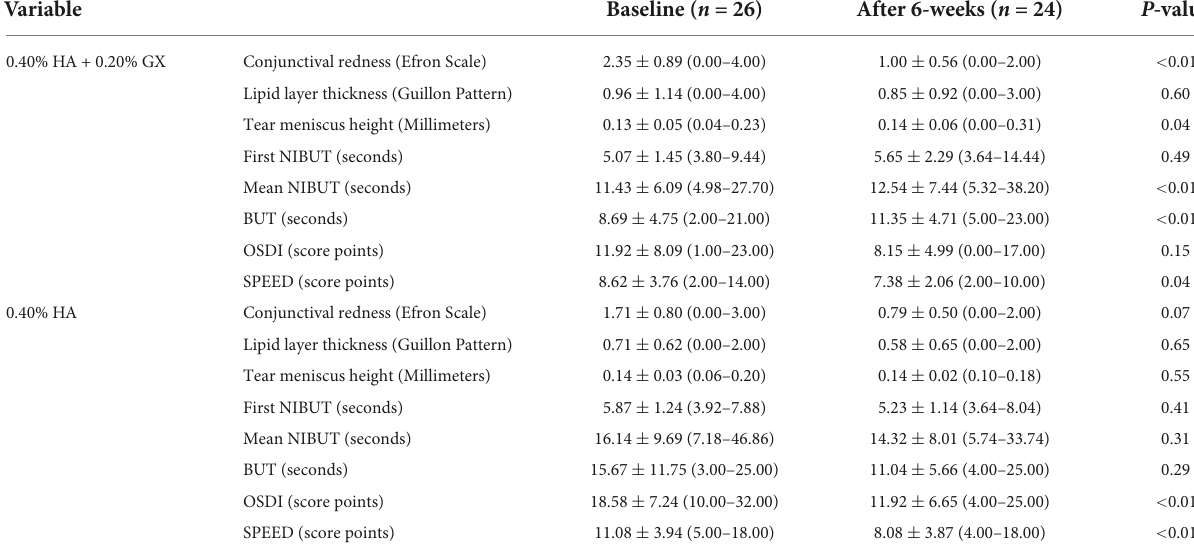
TABLE 2 Ocular surface analyzer comparison previous and after both eyedrop 6-weeks treatment. Variable